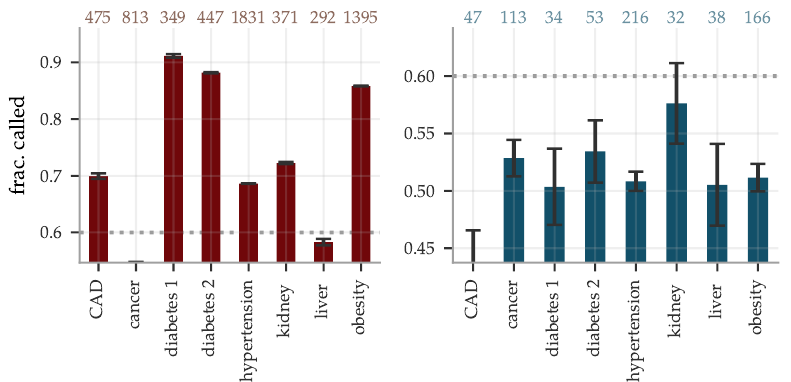
Figure 10. The fractions of sibling pairs with precisely one case and one control called correctly are generally high for BMRS but not much better than chance when predicting from genotypes using gBMRS. The pairs were considered correctly called if the PRS was higher for the affected sibling, without any restriction on the size of the separation. Number of included sibling pairs differed for the two types of predictors and are listed at the top. The error bars indicate ± the standard deviation for five different predictors for BMRS and for 5 × 5 concatenation combinations of predictors in the